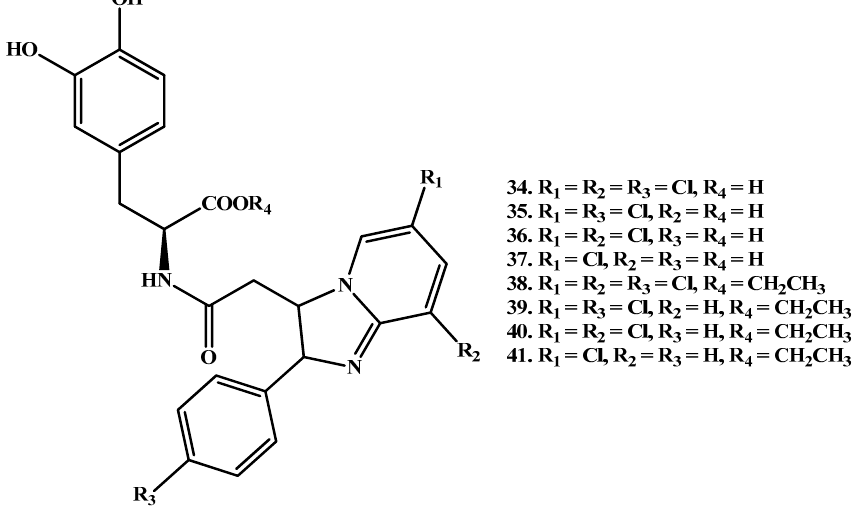
Figure 6. Chemical structures of substituted 2-phenyl-imidazopyridine-3-acetic acid amide prodrugs of LD.